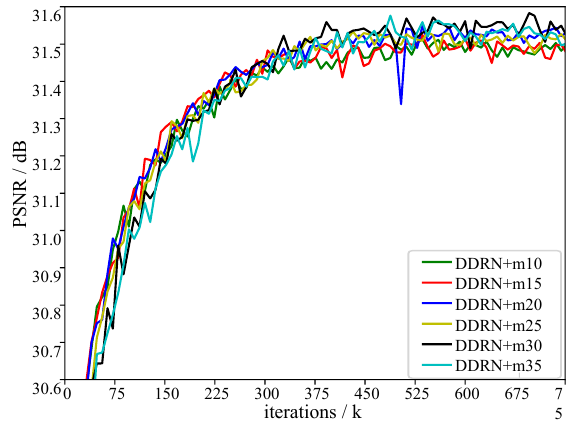
Figure 8. Training process for different depths of DDRN + with scale of 4 and the distillation ratio α of 0.25. We set UDB number m to 10, 15, 20, 25, 30 and 35 while keeping other parameters consistent. On the basis of the experiments, we can obtain the optimal distillation ratio α and UDB depth m for satellite image SR reconstruction, which are set to 0.25 and 30,